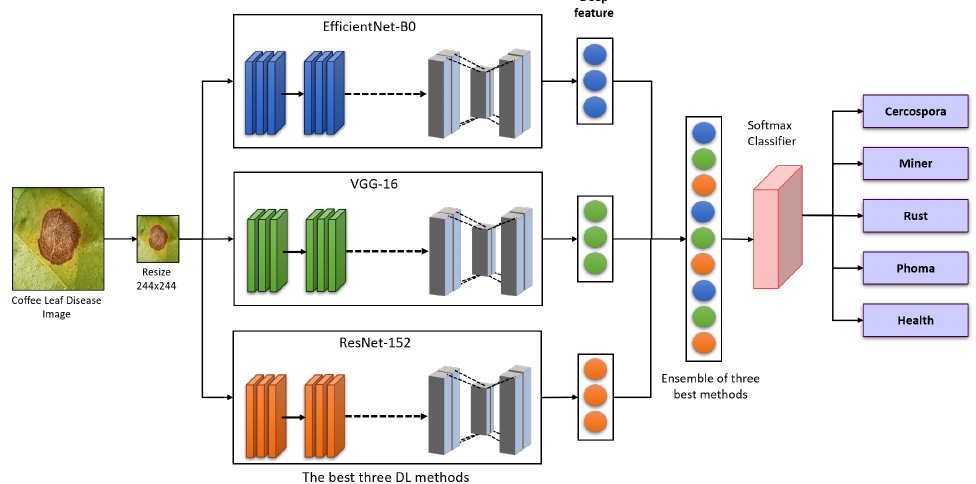
Figure 2. Proposed DL-based ensemble architecture with best three fine-tuned CNN